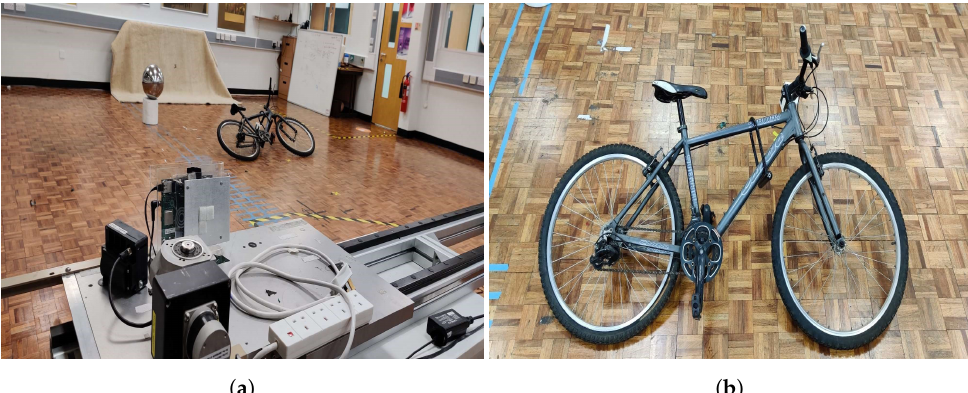
Figure 14. The experimental setup of the extended experiment; ( a ) equipment and ( b ) target